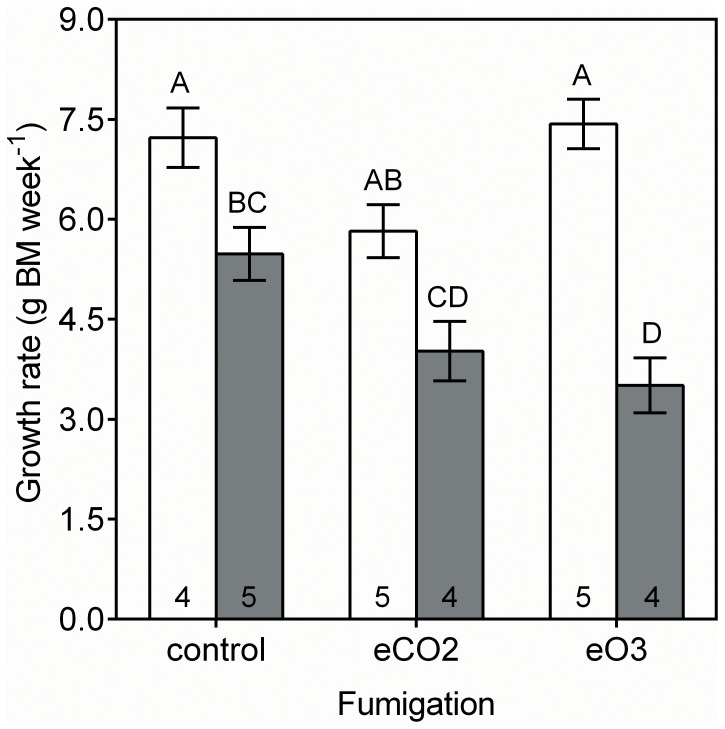
Fumigation and sex effects on weanling vole growth rate.White and gray bars indicate least square means ±SE for male and female voles, respectively. Sample sizes (i.e., replicate voles) for each group mean are indicated inside bars. Significant differences between group means were analyzed using Tukey’s HSD post hoc test, where differences between group means are indicated by different letters.